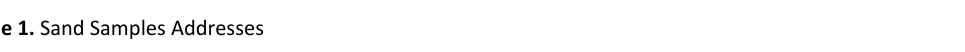
Table 1. Sand Samples Addresses